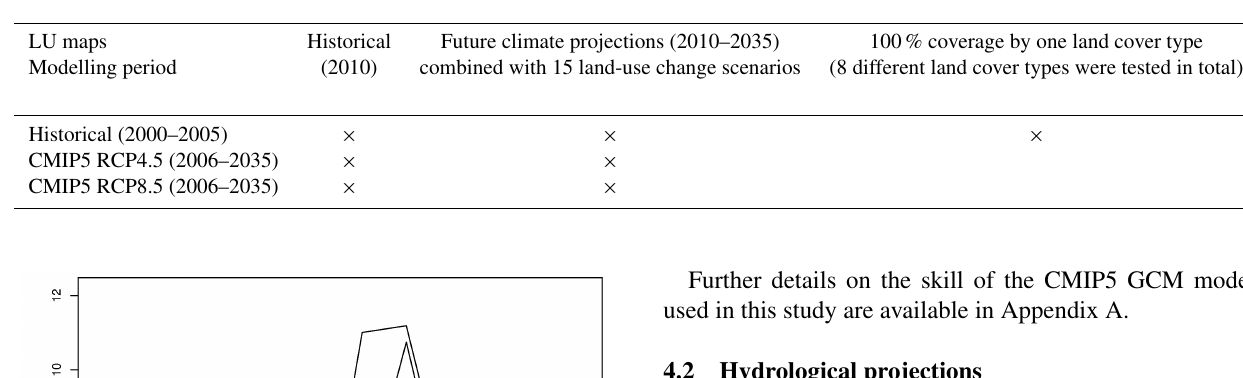
Table 1. Summary of the JULES experiments.